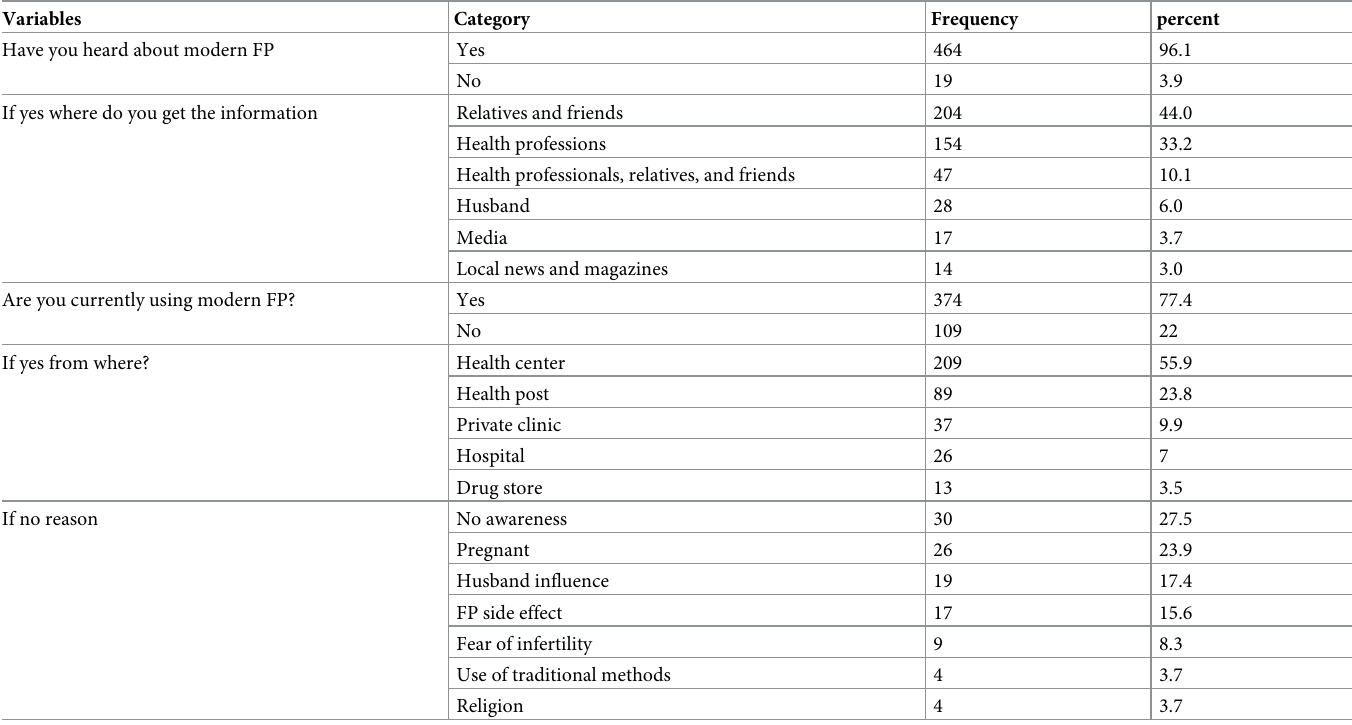
Table 3. Family planning-related factors in South Gondar, Ethiopia, 2017 (n = 483). Variables